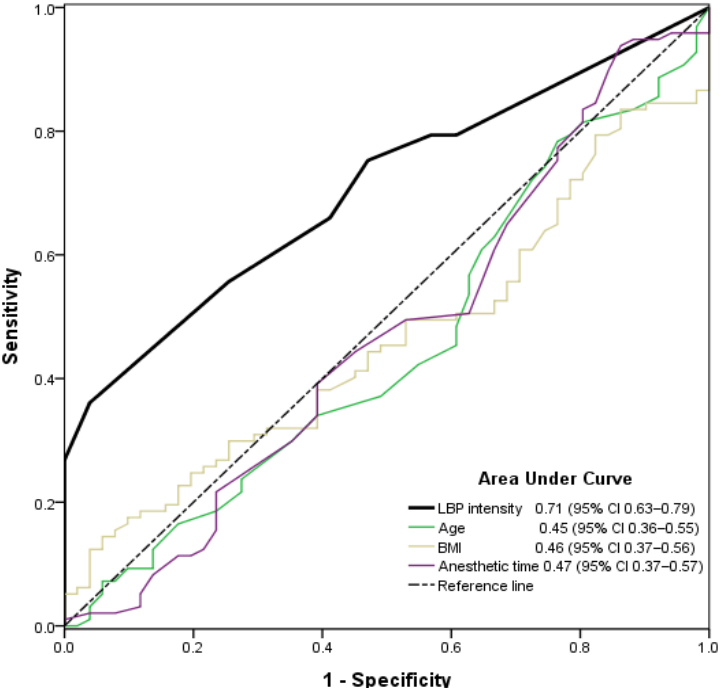
Figure 1. Receiver operating characteristics of preoperative lower back pain intensity, age, body mass index, and anesthetic time to predict moderate-to-severe postoperative pain (numeric rating scale 4–10) in the recovery room. LBP, lower back pain; BMI, body mass index; CI, confidence interval.